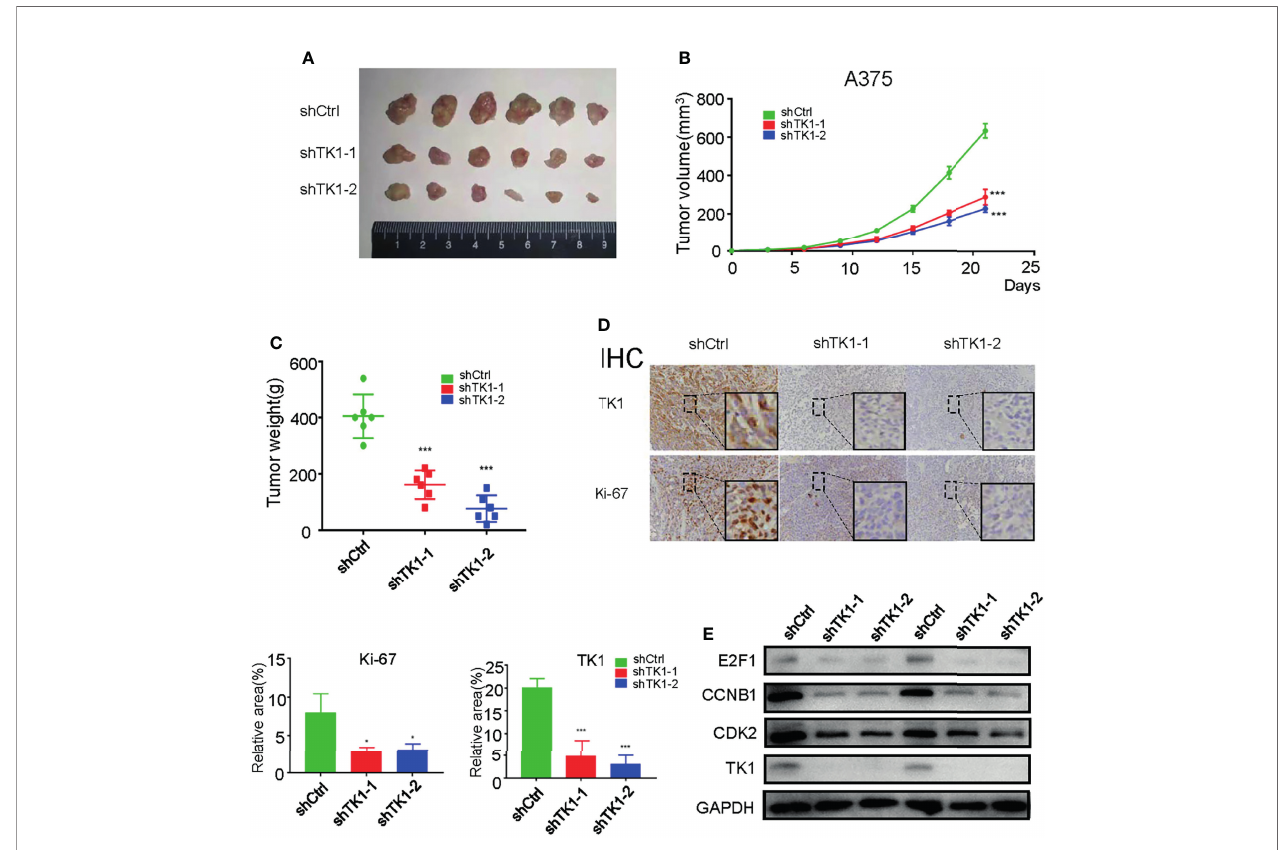
FIGURE 3 | Thymidine kinase 1 (TK1) silencing reduced skin cutaneous melanoma (SKCM) oncogenic progression in vivo . (A) Tumors excised from nude mice after 3 weeks. (B, C) Tumor volumes and weights. (D) Ki-67 and TK1 index of tumors in the control group and TK1 knockdown group. (E) Downstream effectors of the TK1 pathway from tumor tissues were downregulated. *p < 0.05, ***p <